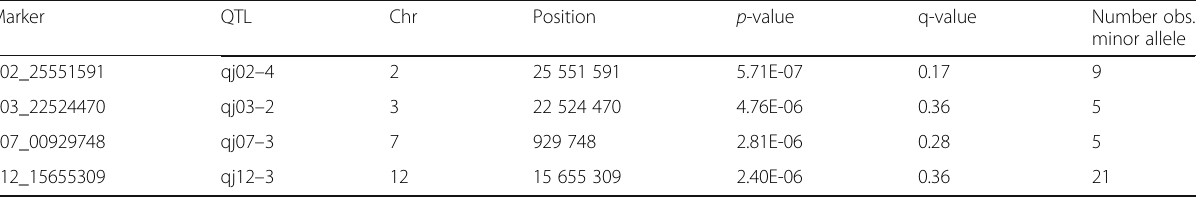
Table 8 Markers significant in the HDRA japonica panel excluding the 8 extreme lines with very wide root cone angle Marker QTL Chr Position p -value q-value Number obs.